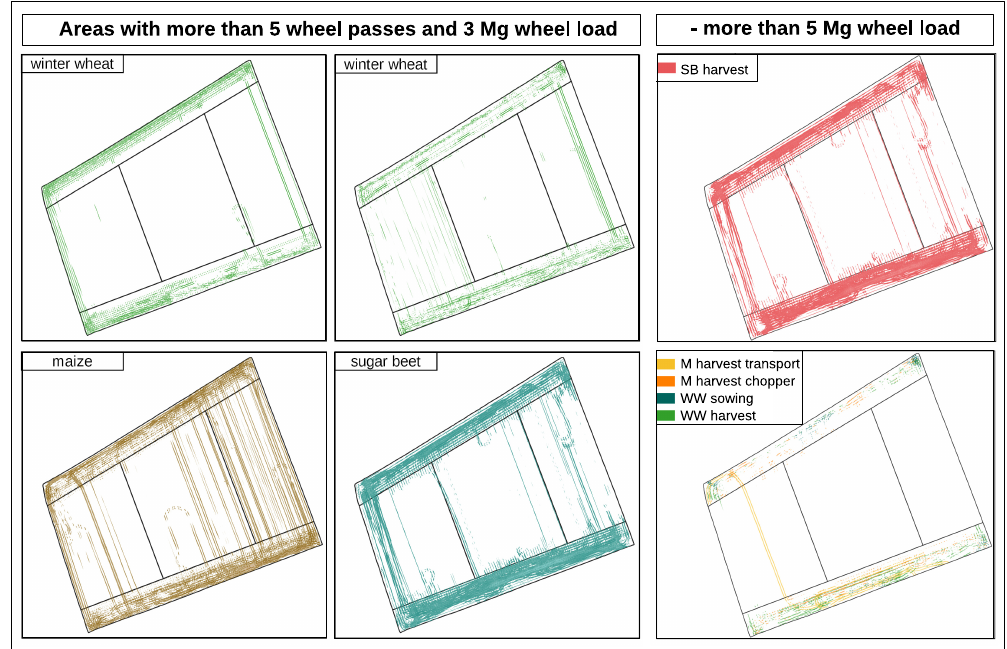
Figure 5. Areas with more than five wheel passes and more than 3 Mg wheel load (left) and more than five wheel passes combined with more than 5 Mg wheel load (right) within single work